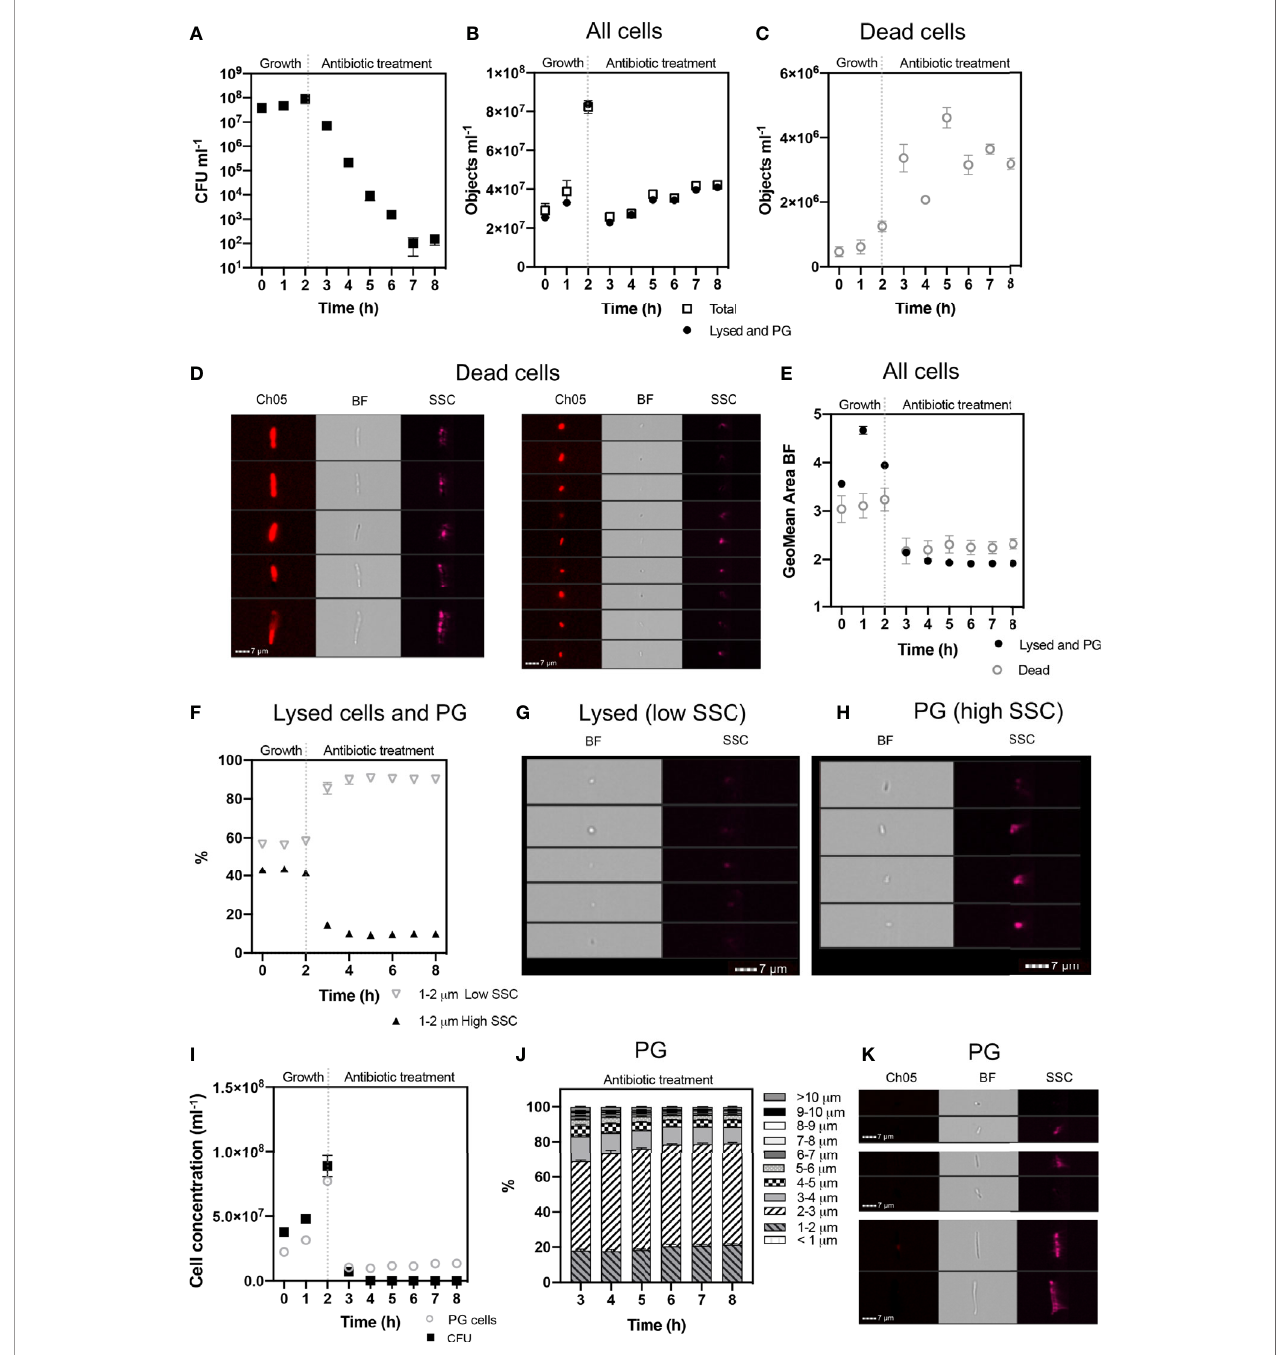
FIGURE 4 | Cell phenotypes of E. coli during 2 h exponential growth and 6 h antibiotic treatment. The growth of viable cells was monitored via colony forming unit (CFU) counts (A) . IFC was used to detect cell concentrations (objects ml-1) of the ‘ Total ’ population and ‘ Lysed and Persister Group ’ (PG) cells (i.e., persister cells and VBNC) (B) . Concentrations of ‘ Dead ’ cells (C) were identi fi ed based on their high PI signal (Ch05: 702/85 nm) and pitted morphology (D) . Dead cells were excluded from ‘ Total ’ cells, to determine ‘ Lysed and PG ’ cells. The geometric mean area of cells demonstrates a decrease in cell size following antibiotic treatment (E) . Lysed cells were determined as having low side scatter (SSC) intensity and increased on the application of antibiotic (F) . Bright fi eld (BF) and SSC images demonstrate the low SSC cells (Lysed) have a compromised cell structure, consisting of small spherical particulate (G) , indicative of lysed debris. In comparison, high SSC (PG) cells demonstrate a rod-shaped structure, highlighting cell integrity (H) . The gating strategy applied for isolating lysed cells from PG cells, is supported by statistically signi fi cant relationship between CFU counts and PG cell concentrations (I) (Spearman ’ s Rank: p < 0.05). Size proportions of the PG cells are shown in 1 µm intervals (J) and exemplar cells from the PG population at 8 h are shown (K) . n = 4; error bars represent standard error of the